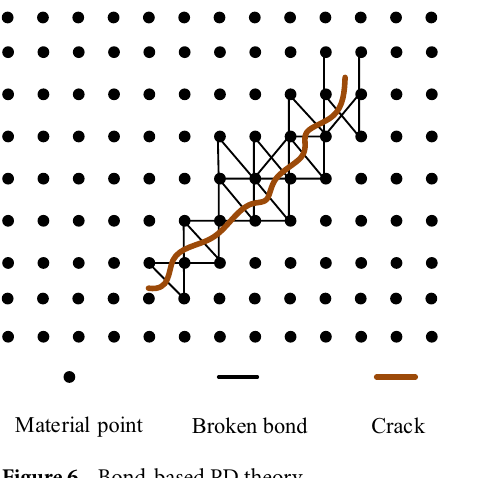
Figure 6. Bond-based PD theory.